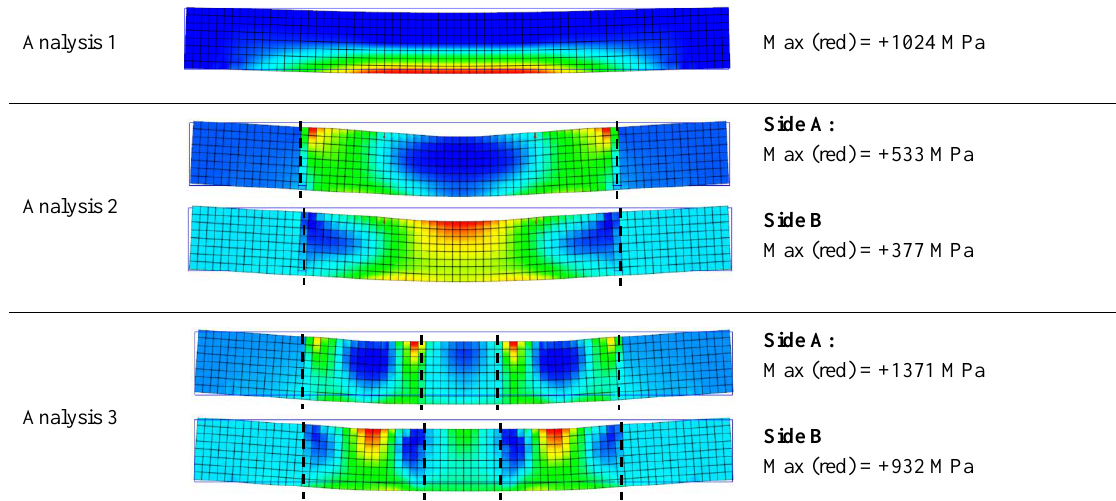
Fig. 6 Stress distribution at 12 mm of vertical displacement, for analyses 1, 2 and 3 (lateral supports are indicated with dashed